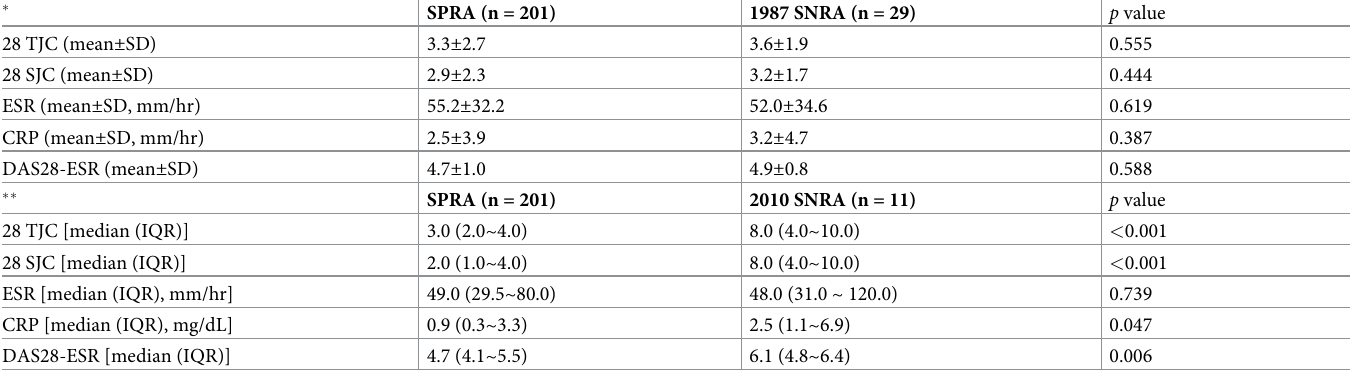
Table 2. Subgroup comparisons of baseline disease activities among SNRA patients grouped according to different diagnostic criteria (1987 ACR criteria vs. 2010 ACR/EULAR criteria) and SPRA patients.